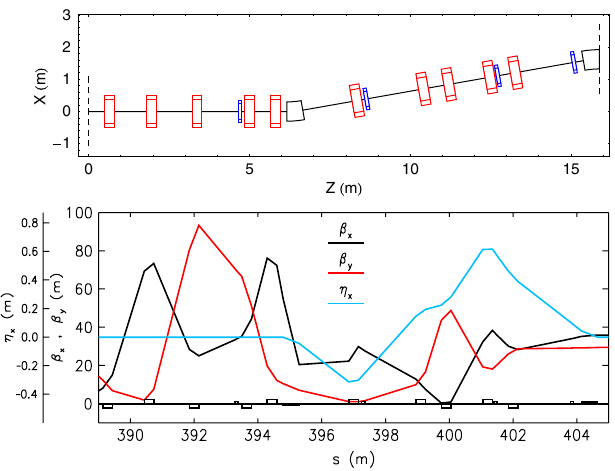
FIG. 6. Top: Floor layout of the arc-to-linac matching achro- mat, sextupoles shown in blue. Bottom: Optics and dispersion functions in arc-to-linac matching achromat.